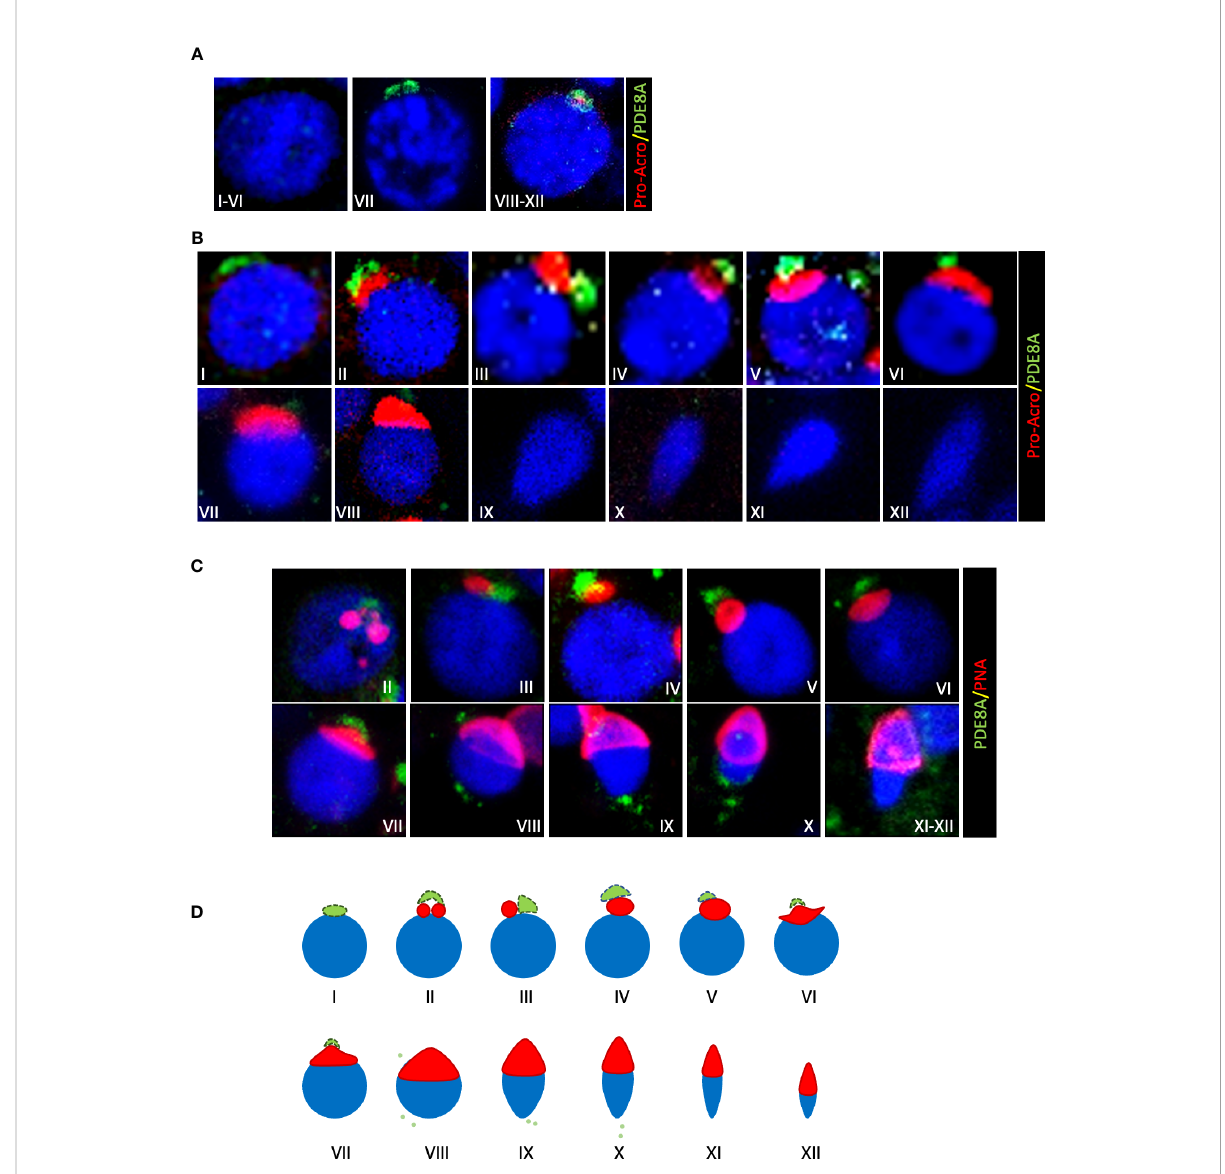
FIGURE 2 Localization of PDE8A in different stages of human spermatogenesis (A) PDE8A localization in human spermatocytes, to better show the differences between them the stages of the whole spermatogenic cycle are arbitrarily sub-divided into three parts. Merged fl uorescent channels DAPI-nuclear staining (blue), pro-acrosin staining (red) and PDE8A fl uorescence (green) are shown. (B) PDE8A localization in human spermatids during the whole spermatogenic cycle are classi fi ed according to pro-acrosin staining. Merged fl uorescent channels DAPI-nuclear staining (blue), pro-acrosin staining (red) and PDE8A fl uorescence (green) are shown. (C) PDE8A localization in human spermatids during the whole spermatogenic cycle classi fi ed according to PNA staining. Merged fl uorescent channels DAPI nuclear staining (blue), PNA staining (red) and PDE8A fl uorescence (green) are shown. (D) PDE8A localization (green/light green) in spermatids in comparison with a schematic representation of the different phases of acrosome biogenesis